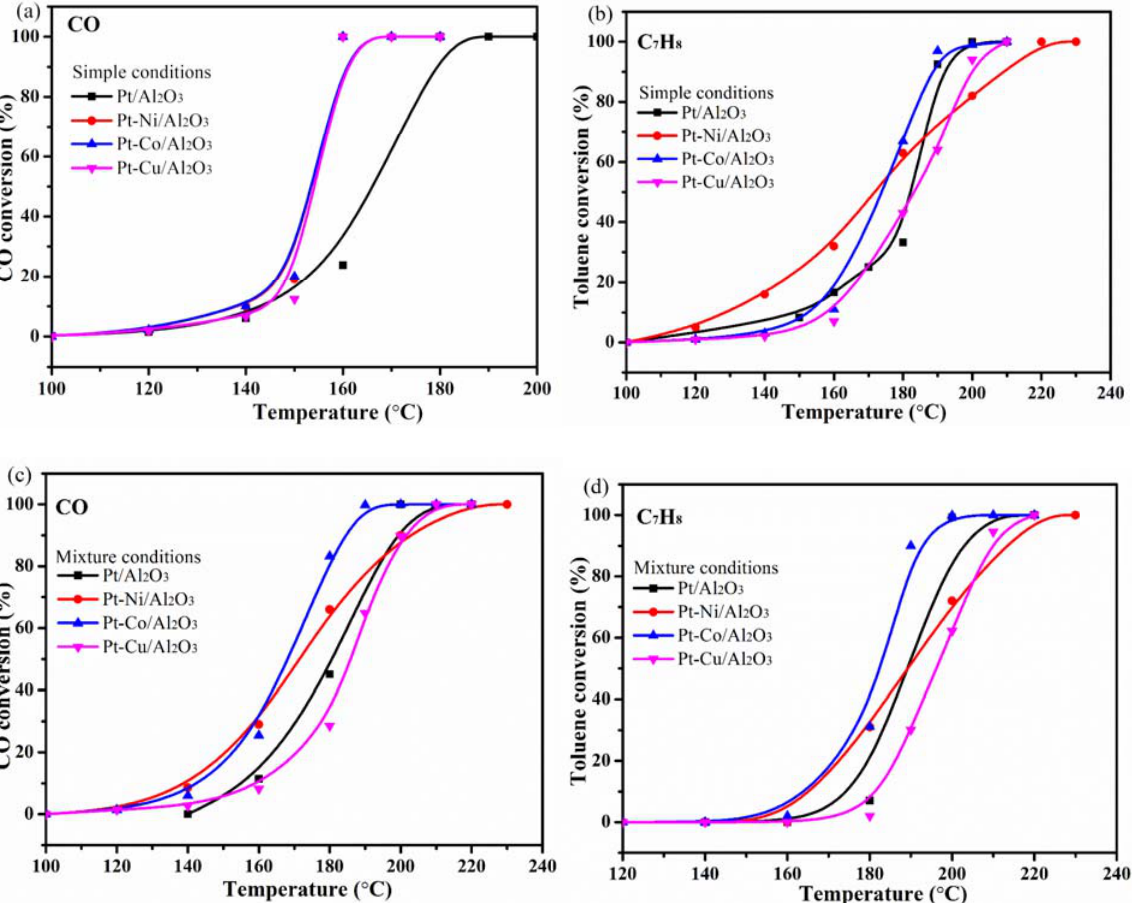
Figure 6. ( a ) CO and ( b ) toluene conversions in simple conditions of these Pt/Al 2 O 3 and Pt ‐ M/Al 2 O 3 samples; ( c ) CO and ( d ) toluene conversion in mixture conditions of these Pt/Al 2 O 3 and Pt ‐ M/Al 2 O 3 samples. Simple conditions: 1.0 vol.% CO or 1000 ppm toluene balanced with air; Mixture conditions: 1.0 vol.% CO and 1000 ppm toluene balanced with air. All the reactions were kept at WHSV = 60,000 mL g − 1 h − 1 .